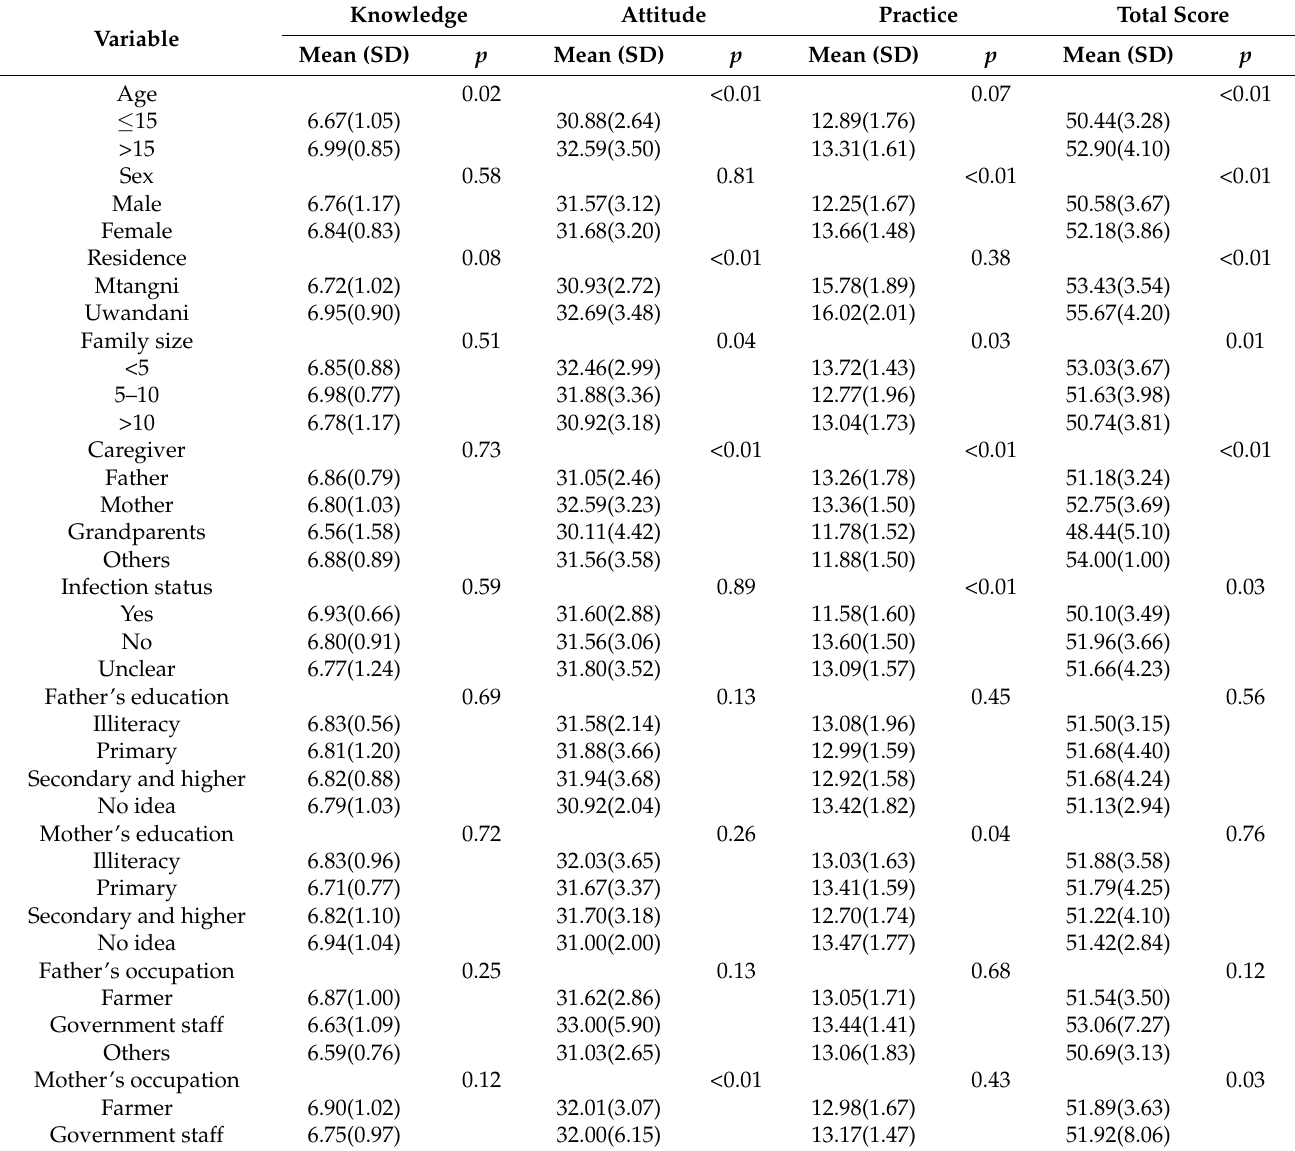
Table 3. Demographic determinants of participants’ KAP scores related to